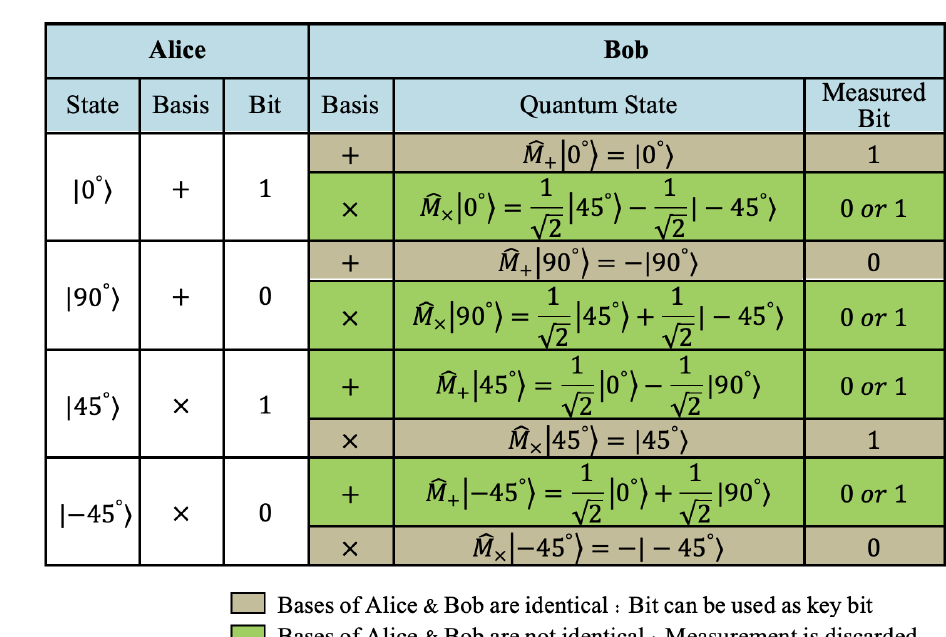
Figure 5. Alice and Bob basis, bits and measured bit—without Eve.